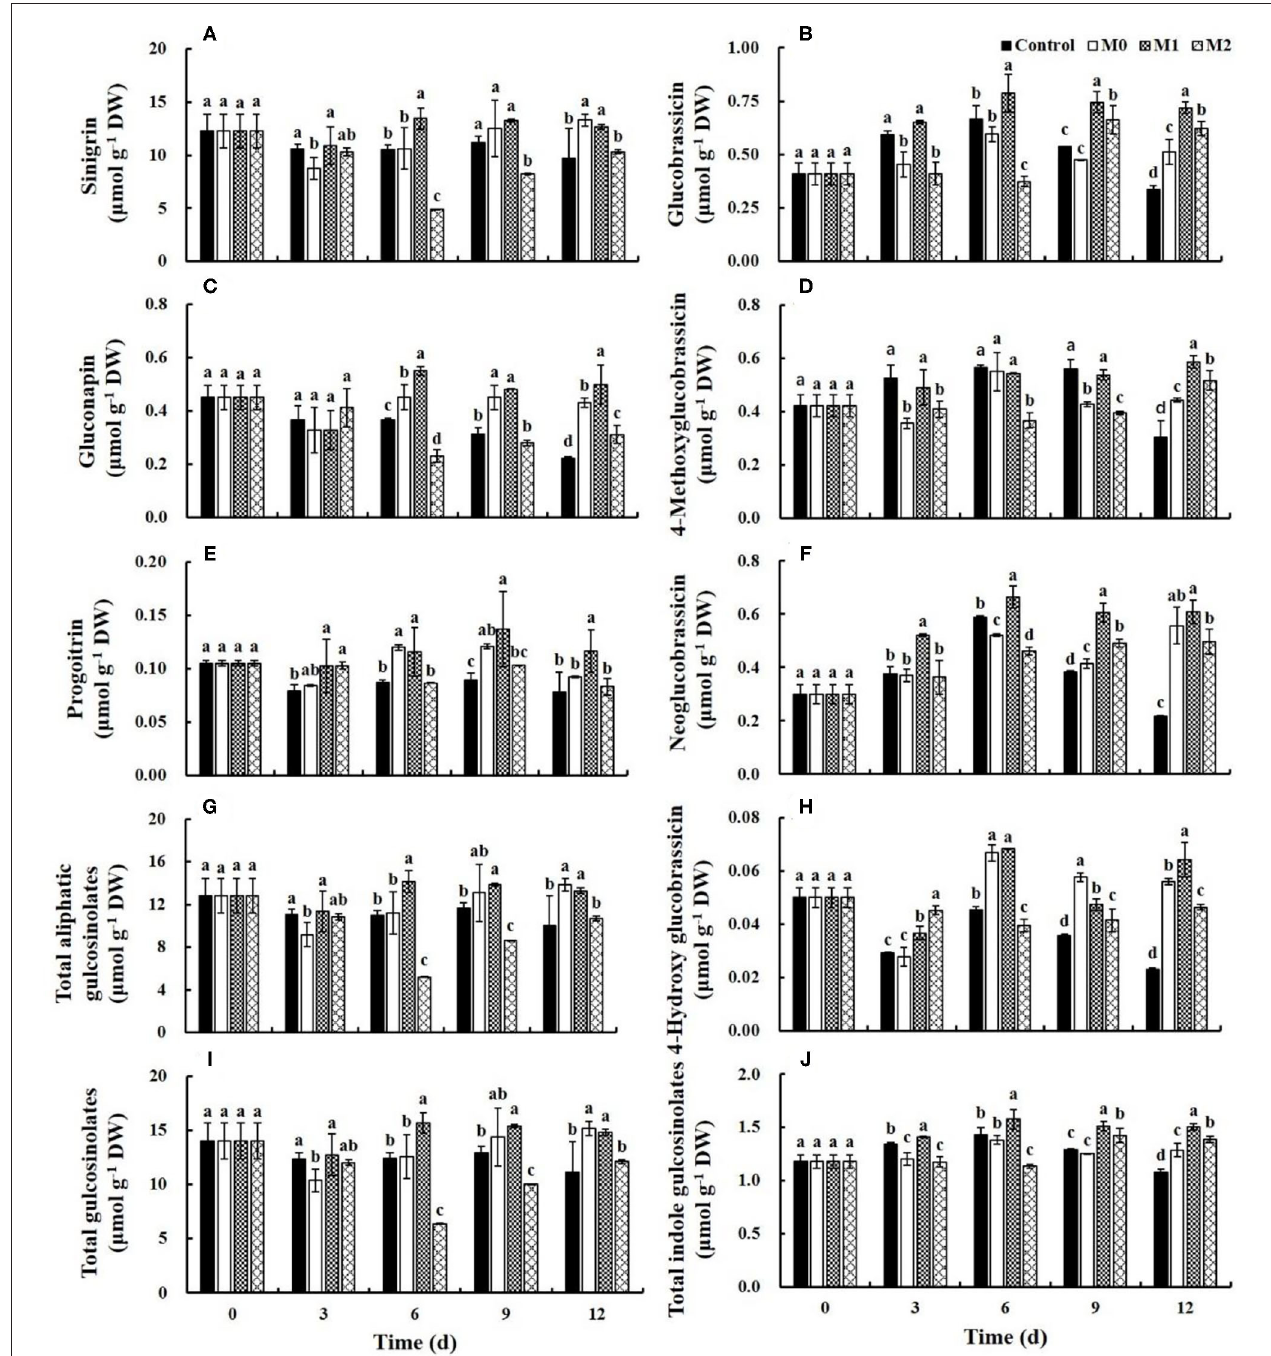
FIGURE 5 | Glucosinolates content of different baby mustard lateral buds during storage at 4 ◦ C under different MAP treatments. (A) sinigrin; (B) glucobrassicin; (C) gluconapin; (D) 4-methoxyglucobrassicin; (E) progoitrin; (F) neoglucobrassicin; (G) total aliphatic gulcosinolates; (H) 4-hydroxy glucobrassicin; (I) total gulcosinolates; (J) total indole gulcosinolates. Different letters in the figure indicate statistically significant differences among treatments for each storage day ( P < 0.05). M0 indicates packaging with no holes; M1 indicates packaging with 6mm in diameter holes; M2 indicates packaging with 12mm in diameter holes. its visual quality (5). Similar findings have also been obtained for broccoli florets (4), Toona sinensis (12), and watercress